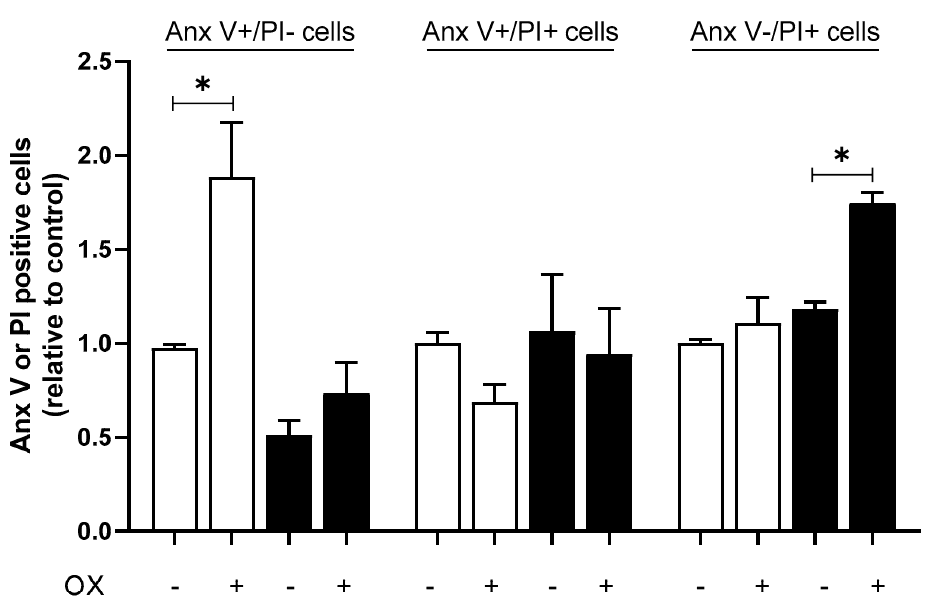
Figure 8. Cell death in HEK293-hOCT2 cells treated with OX under fed and starvation conditions. Apoptosis and necrosis were measured by means of annexin V (Anx V) staining and propidium iodide (PI) uptake in HEK293-hOCT2 cells after 24 h incubation with 100 µM OX under fed (open bars) or starvation (closed bars) conditions. Early apoptotic cells show Anx V positive (+)/PI negative ( − ) staining patterns; late apoptotic cells exhibited Anx V+/PI+ staining patterns due to a loss of plasma membrane integrity. Necrotic cells were defined as Anx V − /PI+ cells. Data are expressed relative to cells incubated with fed medium without OX and given as mean ± SEM of 3 independent experiments. * show statistically significant difference ( p < 0.05) between the indicated groups (unpaired t -test).